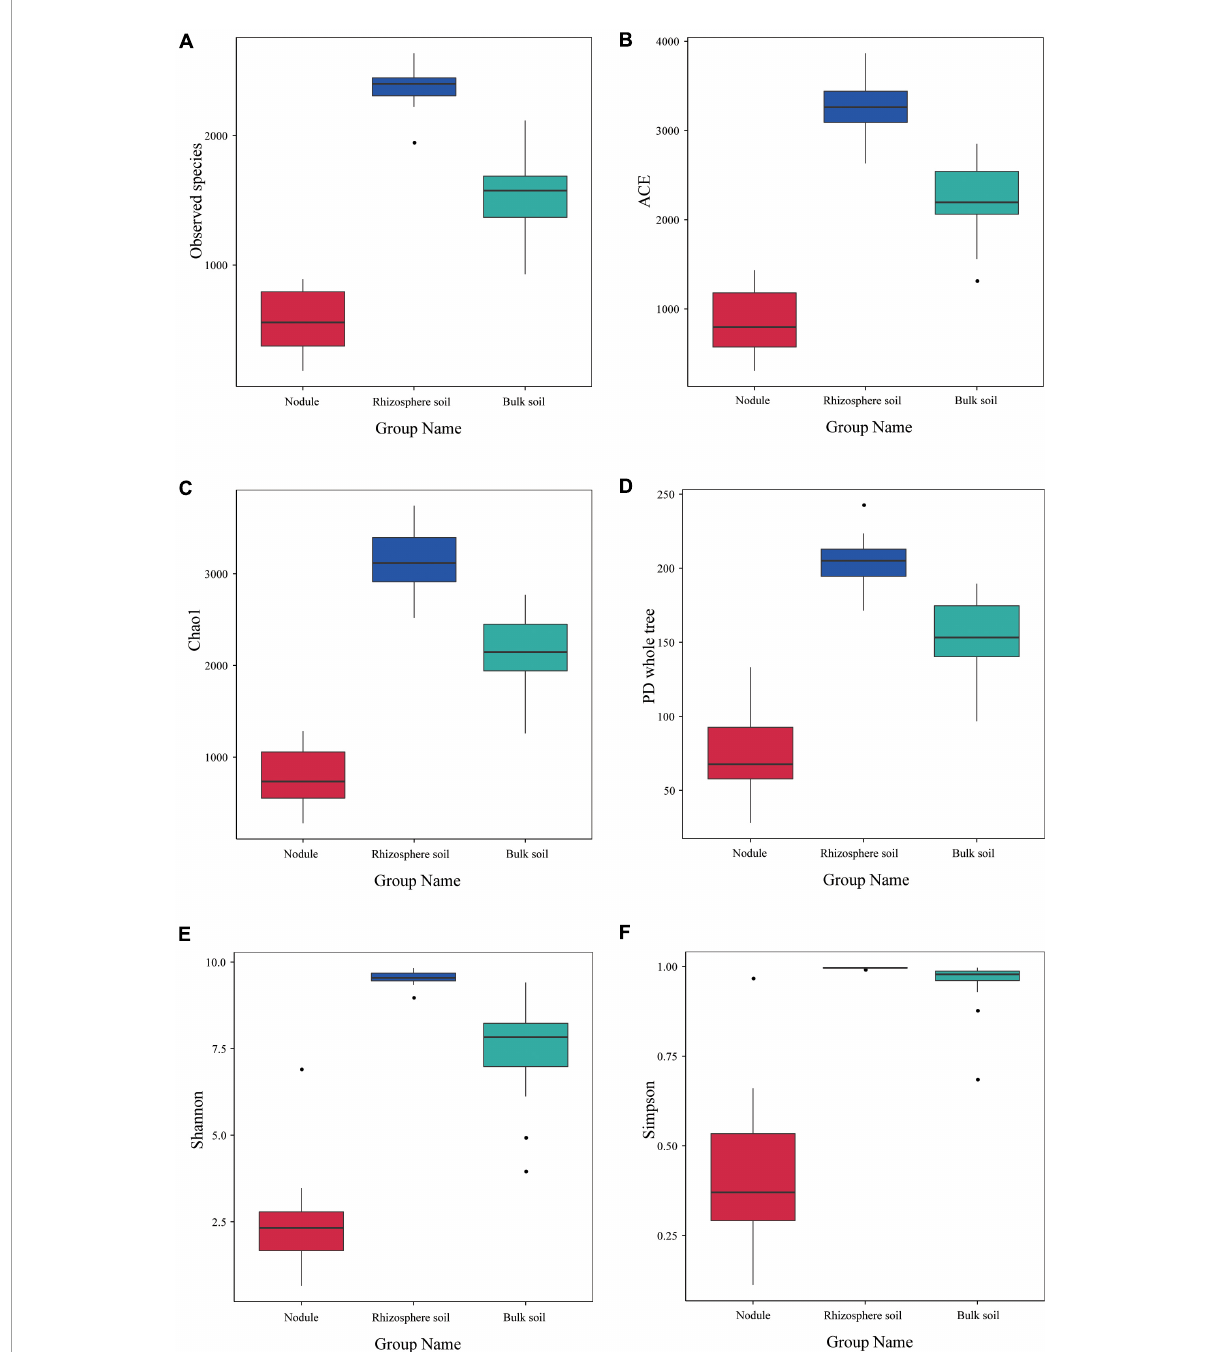
FIGURE5 Alpha diversity index of the microbial communities within the three types of S . davidii samples. (A–F) represent observed species, and the results of the ACE, Chao1, PD Whole Tree, the Shannon and Simpson index of the different samples of nodules, rhizosphere soil and bulk soil. Statistical analyses were performed by the paired Wilcoxon rank-sum test and Tukey’s test. The significance is denoted by asterisks where · P < 0.05.